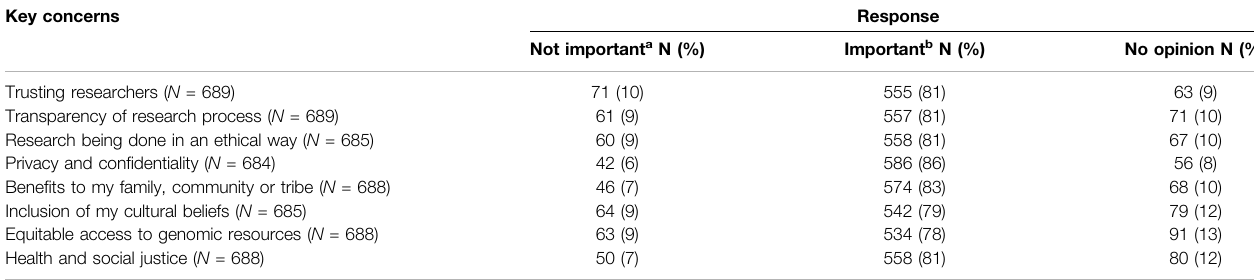
TABLE 2 | Respondents concerns about genetic research involving Navajo people. Key concerns